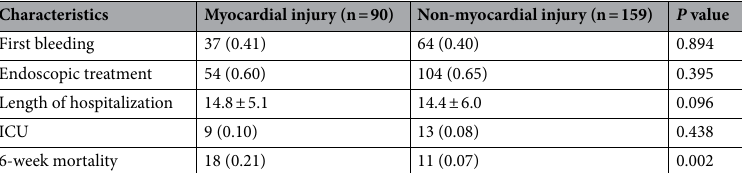
Table 5. Treatment and prognosis of patients in the myocardial injury group and non-myocardial injury group.